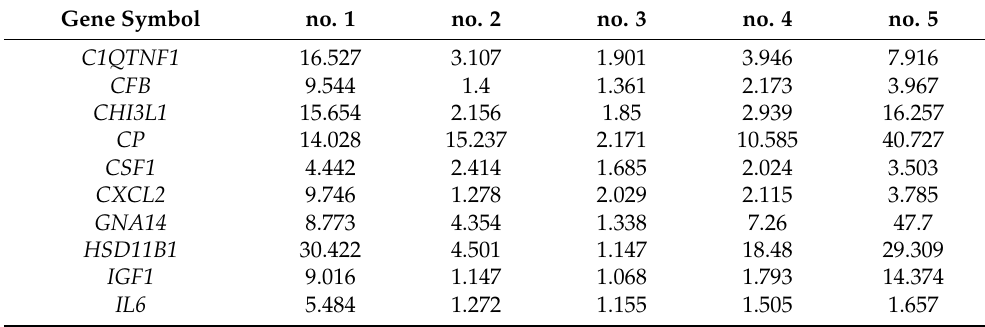
Table 4. Expression log2 fold change values of 24 genes related to osteoporosis, obesity, and diabetes in mesenchymal stromal cells from participants in the control group based on RNA-sequencing data. Gene Symbol no. 1 no. 2 no.